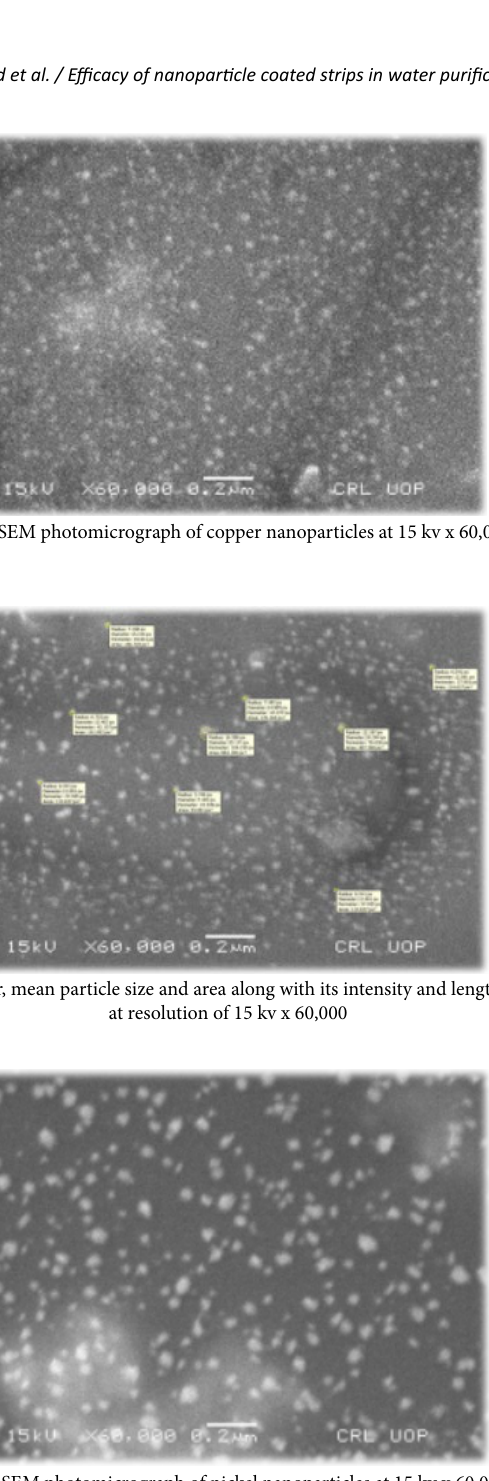
Fig. 6. Photomicrographs of Digimizer, mean particle size and area along with its intensity and length of nickel oxide nanoparticles at resolution of 15 kv x 60,000